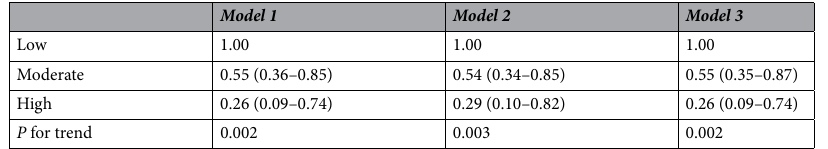
Table 2. Association of physical activity level with dynapenia. Data are odds ratios (95% confidence interval). Model 1: adjusted for age and sex. Model 2: based on model 1, further adjusted for body mass index, smoking, alcohol, education, hypertension, diabetes, anemia, asthma, cardiovascular disease, depression, and total calorie intake. Model 3: based on model 2, further adjusted for Global Initiative for Chronic Obstructive Lung Disease (GOLD) stage.